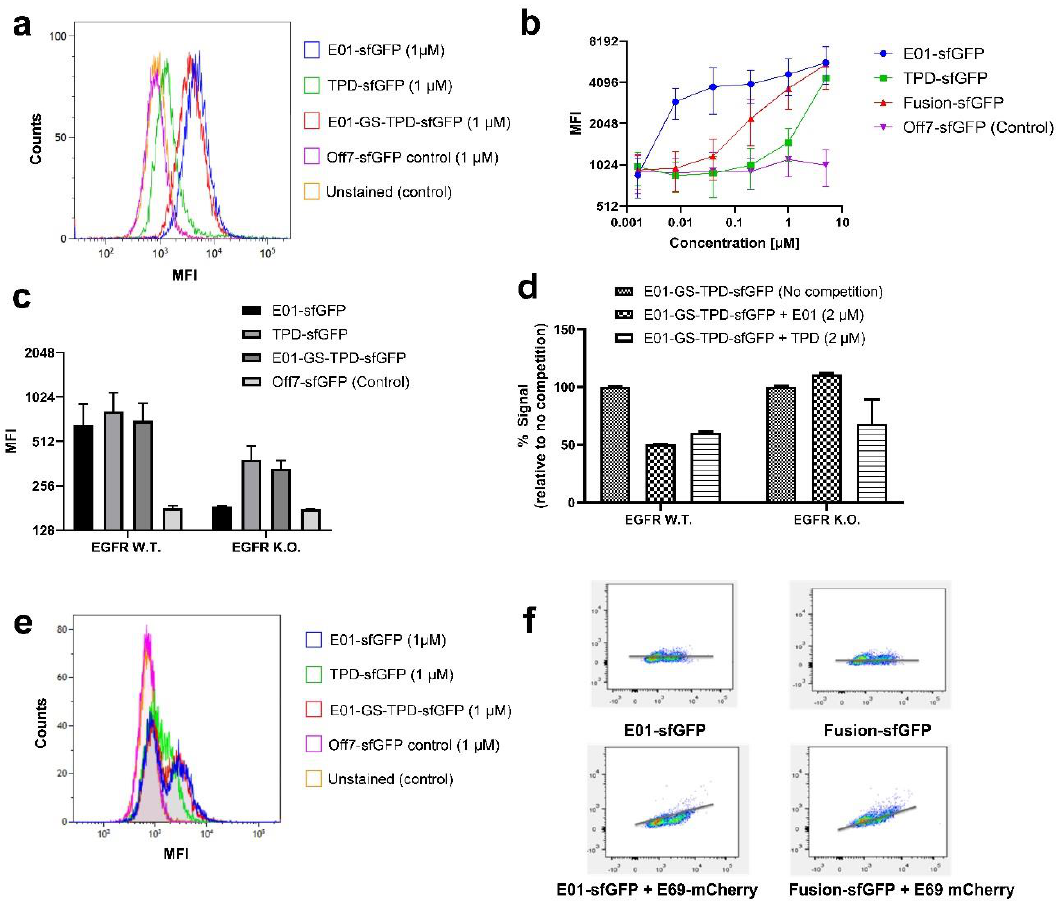
Figure 2. Analytical flow cytometry assays reveal binding of fusion protein E01-GS-TPD. ( a ) overlay histogram of A549 EGFR (+/+) cells treated with the fluorescently tagged recombinant proteins used in this study (mean fluorescence intensities (MFI)). ( b ) binding curves upon incubation of A549 EGFR (+/+) cells with E01-sfGFP, TPD-sfGFP, fusion protein E01-GS-TPD-sfGFP, or negative control DARPin Off7-sfGFP. MFI, and their half-peak coefficient of variation (%CV) are shown for each concentration. ( c ) binding of each protein to A549 EGFR (+/+) or A549 EGFR (−/−) cells. ( d ) competition assays using A549 cells treated with fluorescently labeled fusion protein E01-GS-TPD-sfGFP in